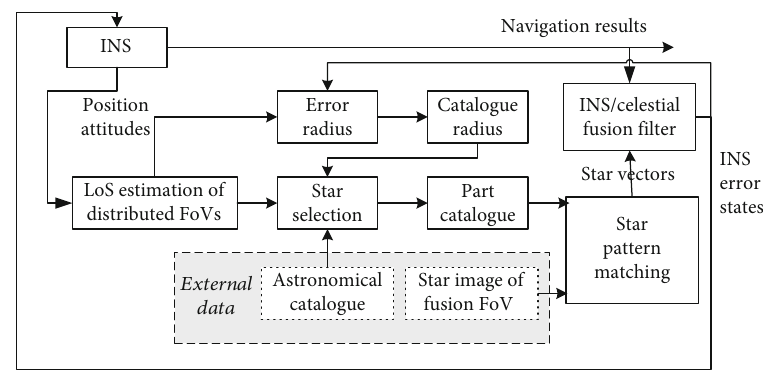
Figure 4: Inertial-aided star pattern matching scheme for distributed